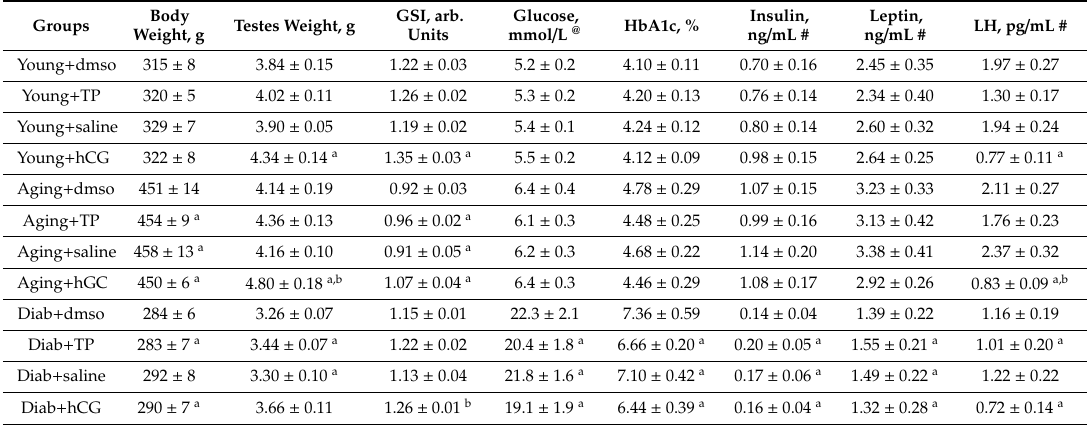
Table 1. The body and testes weight, gonadosomatic index (GSI), and blood levels of glucose, glycated hemoglobin (HbA1c), insulin, leptin and luteinizing hormone (LH) in young adult, aging and diabetic male Wistar rats.